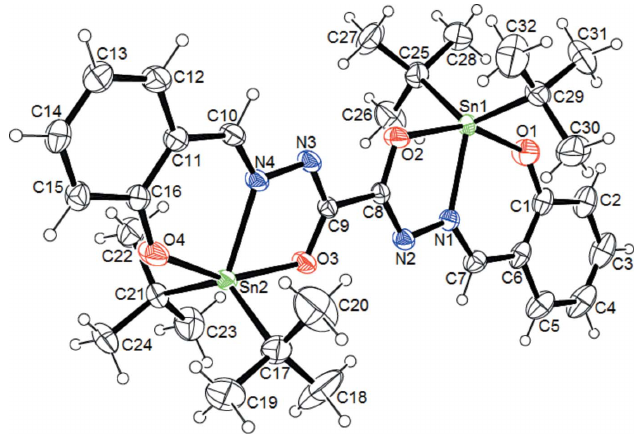
Figure 1 The molecular structure of the title compound, showing the atom- numbering scheme. Displacement ellipsoids are plotted at the 50% probability level.